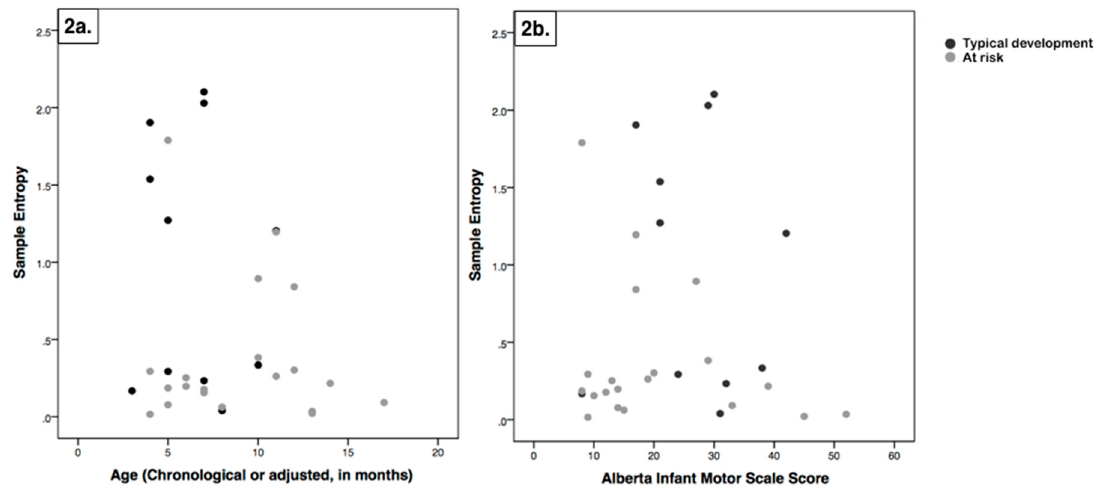
Figure 2. Sample entropy values for each infant by chronological or adjusted age in months ( a ) and by Alberta Infant Motor Scale scores ( b ). Infants with typical development are shown by black dots, while infants at risk are shown by gray dots. Table 2. Sample Entropy Values by Group.